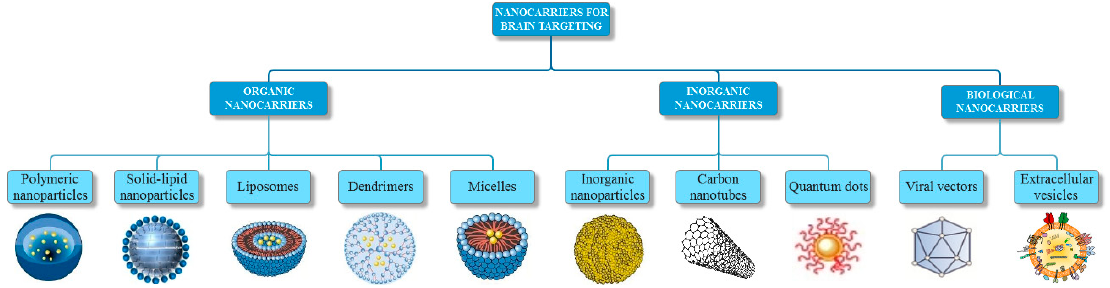
Figure 1. A summary of the various types of nanocarriers for brain targeting.